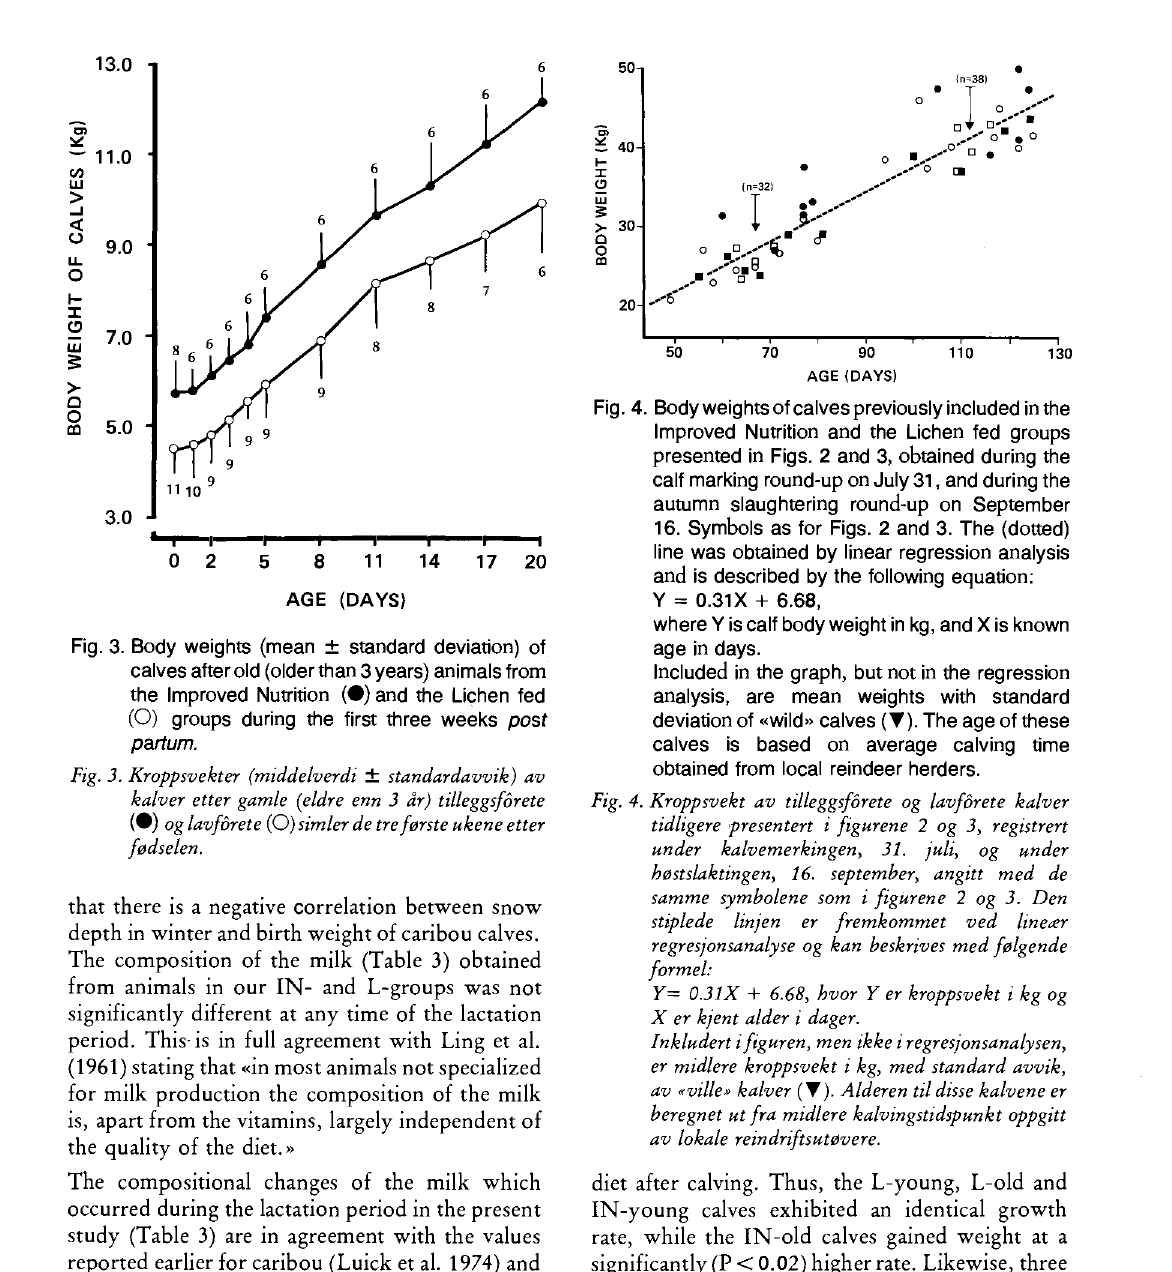
Fig. 3. Body weights (mean ± standard deviation) of calves after old (older than 3 years) animals from the Improved Nutrition (•) and the Lichen fed (O) groups during the first three weeks posf partum. Fig. 3. Kroppsvekter (middelverdi ± standardavvik) av kalver etter gamle (eldre enn 3 år) tilleggsforete (©) og lavforete (O) simler de tre første ukene etter fødselen. that there is a negative correlation between snow